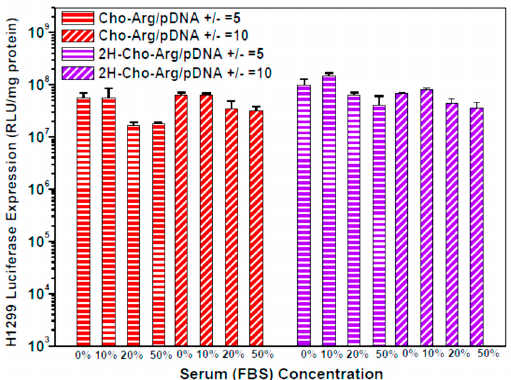
Figure 5. Luciferase gene transfection efficiency for the steroid-based cationic lipids/pDNA lipoplexes under +/ − charge ratios of 5 and 10 in the presence of various concentrations of serum in H1299 cell lines.